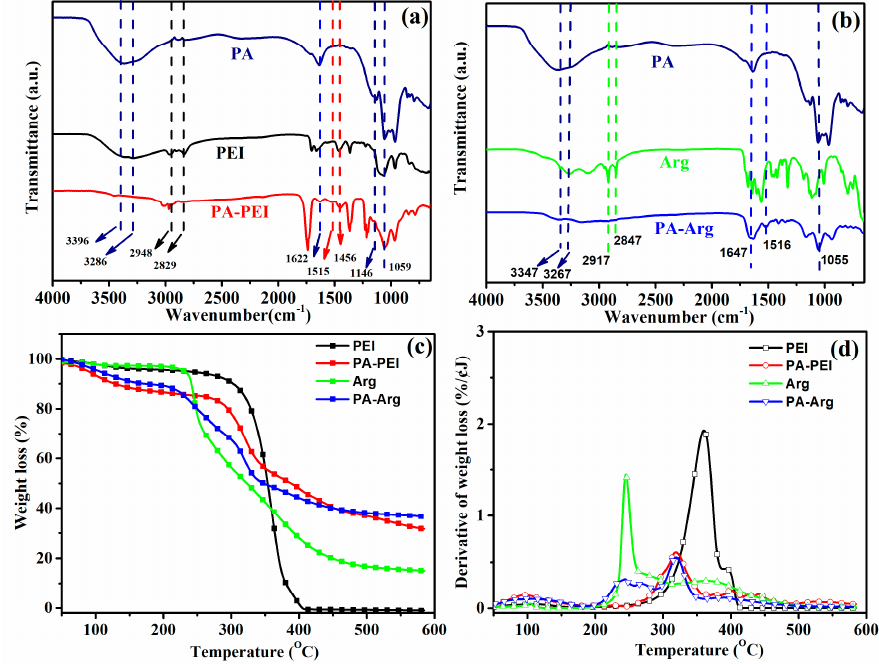
Figure 2. ( a ) FTIR spectrum of PA, PEI, PA-PEI ( b ) FTIR spectrum of PA, Arg, PA-Arg, ( c ) TGA and ( d ) DTG curves of PEI, PA-PEI, Arg, and PA-Arg under N 2 conditions. Table 2. TGA and DTG data of PEI, PA-PEI, Arg, and PA-Arg materials under N 2 atmosphere.